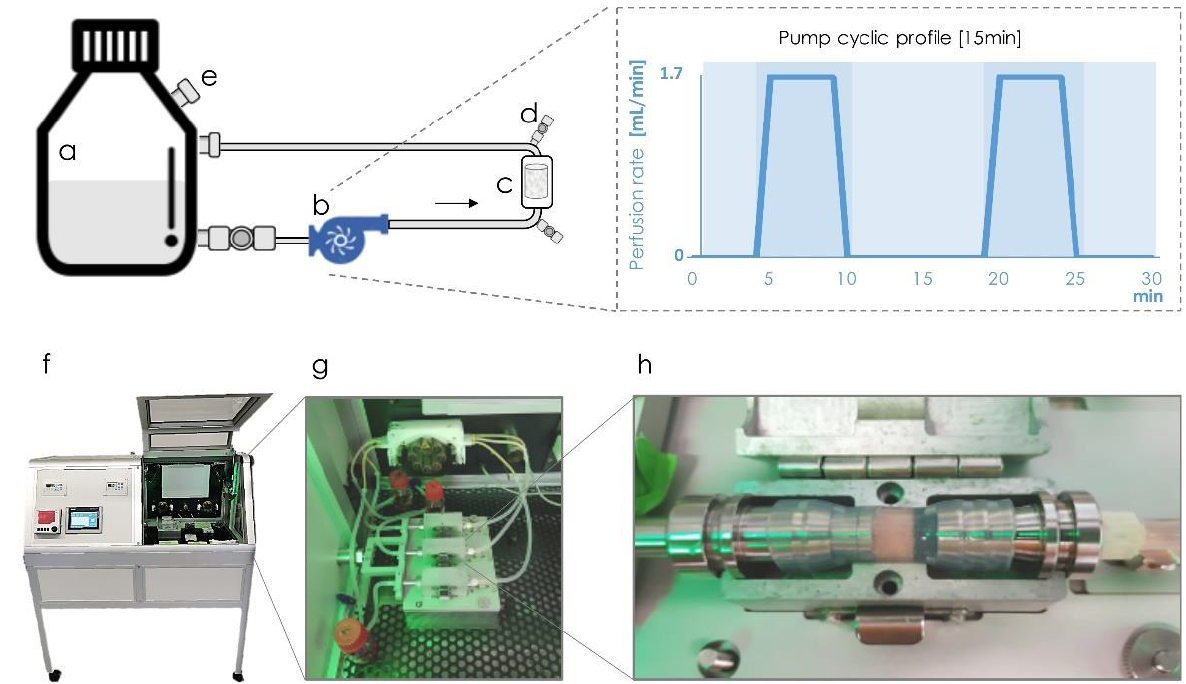
Figure 7. Schematic representation of the bioreactor design. The cell culture media is kept in a controlled environment at 37 ◦ C in a flask reservoir ( a ) and driven through silicon tubes with a controllable pump ( b ) towards the scaffold chamber ( c , h ) and back to the reservoir. The system includes additional connections ( d ) strategically in the inlet and outlet of the chamber for cell seeding. A valve equipped with a sterile filter ( e ) on the reservoir guarantees the gas exchange with the external environment. The pump is programmed to actively perfuse cell culture medium for 5 min at a rate of 1.7 mL/min and stop for 10 min in cycles of 15 min, as illustrated on the right graph. The incubation chamber ( f ) includes temperature and CO 2 control where multi bioreactor systems can be mounted in parallel ( g